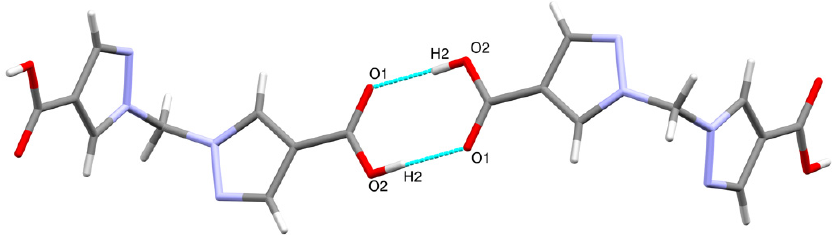
Figure 2. Hydrogen-bonded carboxyl–carboxyl cyclic dimers between H 2 bpmdc molecules.